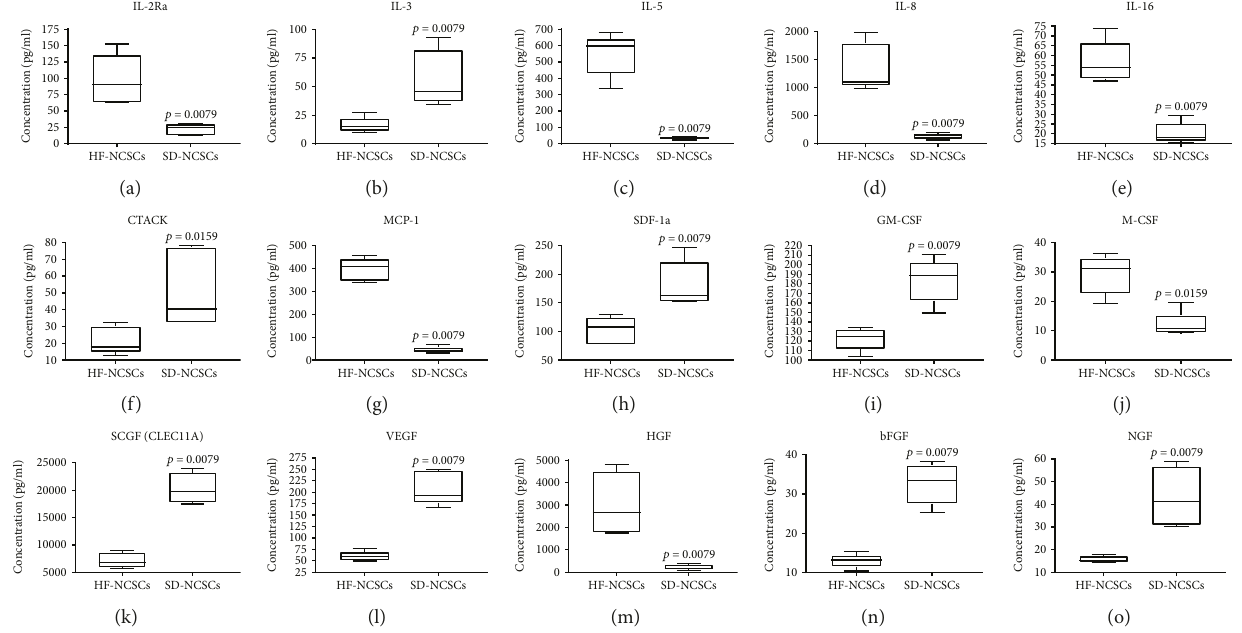
Figure 8: Secretion patterns of chemokines, cytokines, and growth factors by adult NCSCs from hair follicle and skin